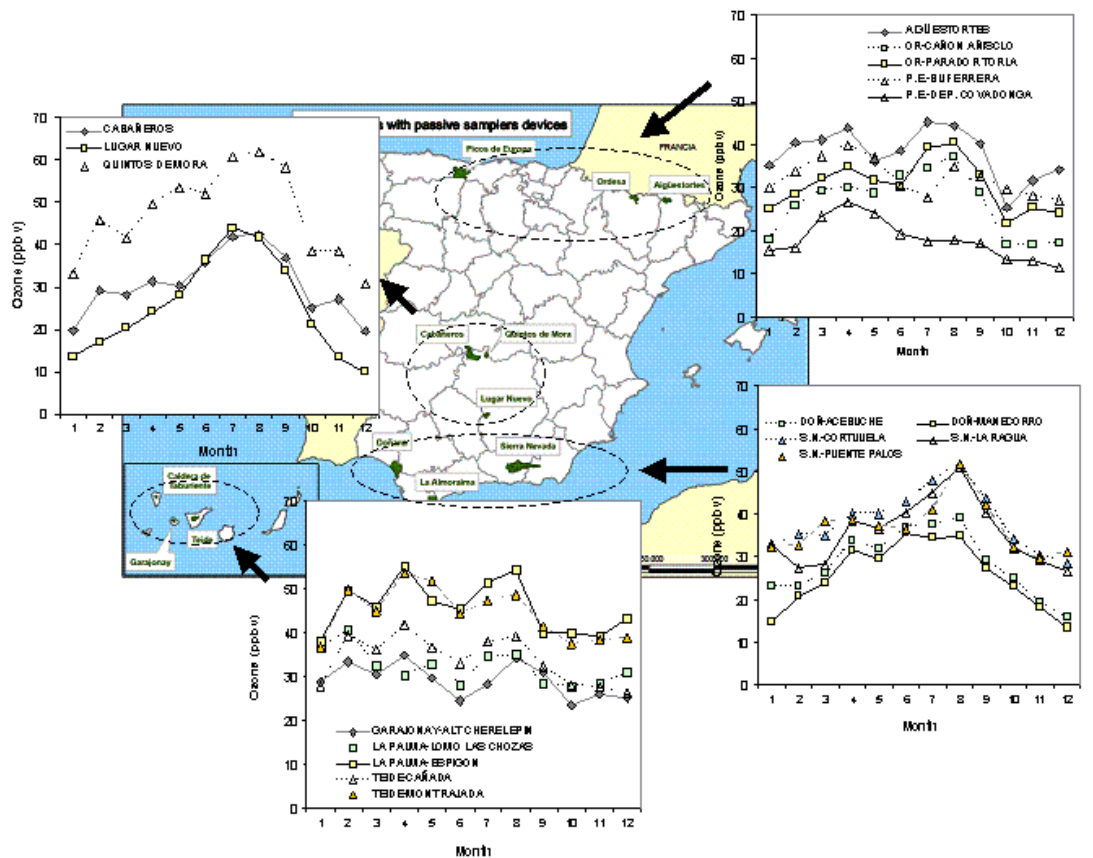
FIGURE 7 . Yearly averaged cycles in different regions for the study period (July 2001–July